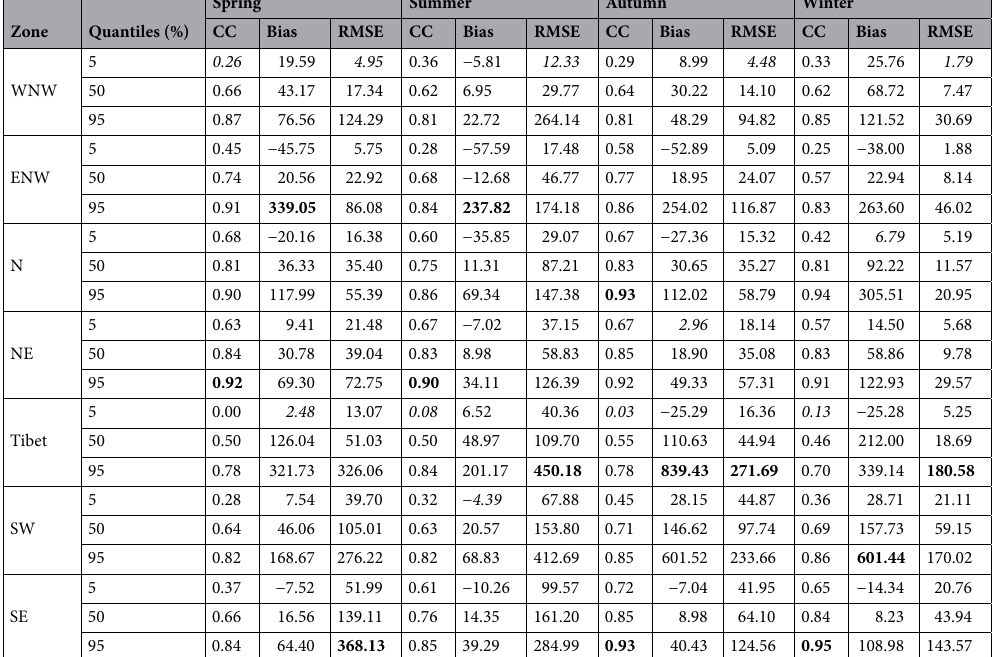
Table 1. 5%, 50%, and 95% quantiles of the CC (), Bias (%), RMSE (mm/month) for annual and seasonal precipitation data between ERA5 and observation in seven zones of China. The maximum and minimum values of each column are shown with bold and italics style, respectively, except for the Bias, whose minimum value is shown as the absolute minimum